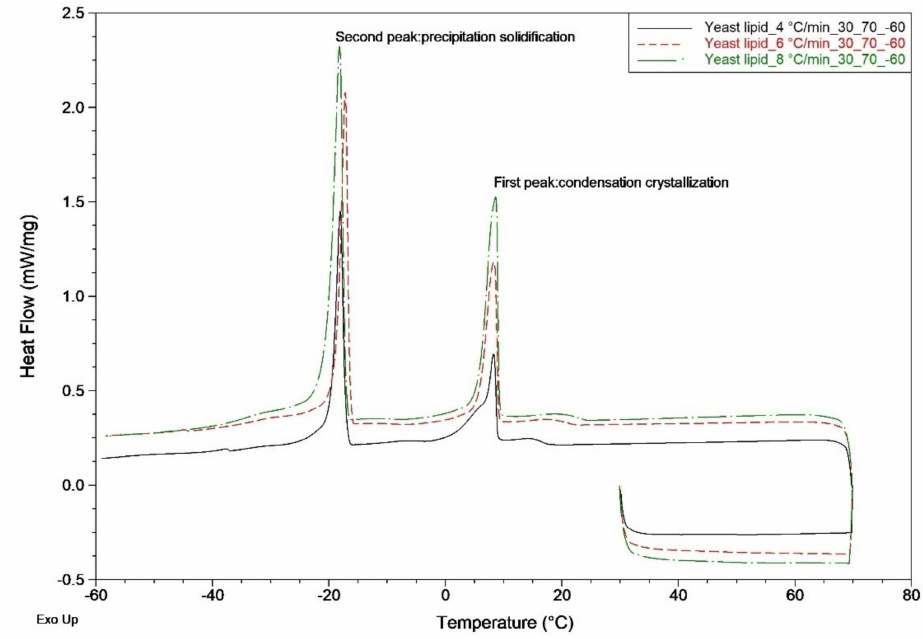
Figure 5. R. mucilaginosa lipids measured with DSC heating rates of 2, 4, 6, and 8 ◦ C/min, with the operating temperature ranging from 30 to 70 ◦ C, and then cooling to − 60 ◦